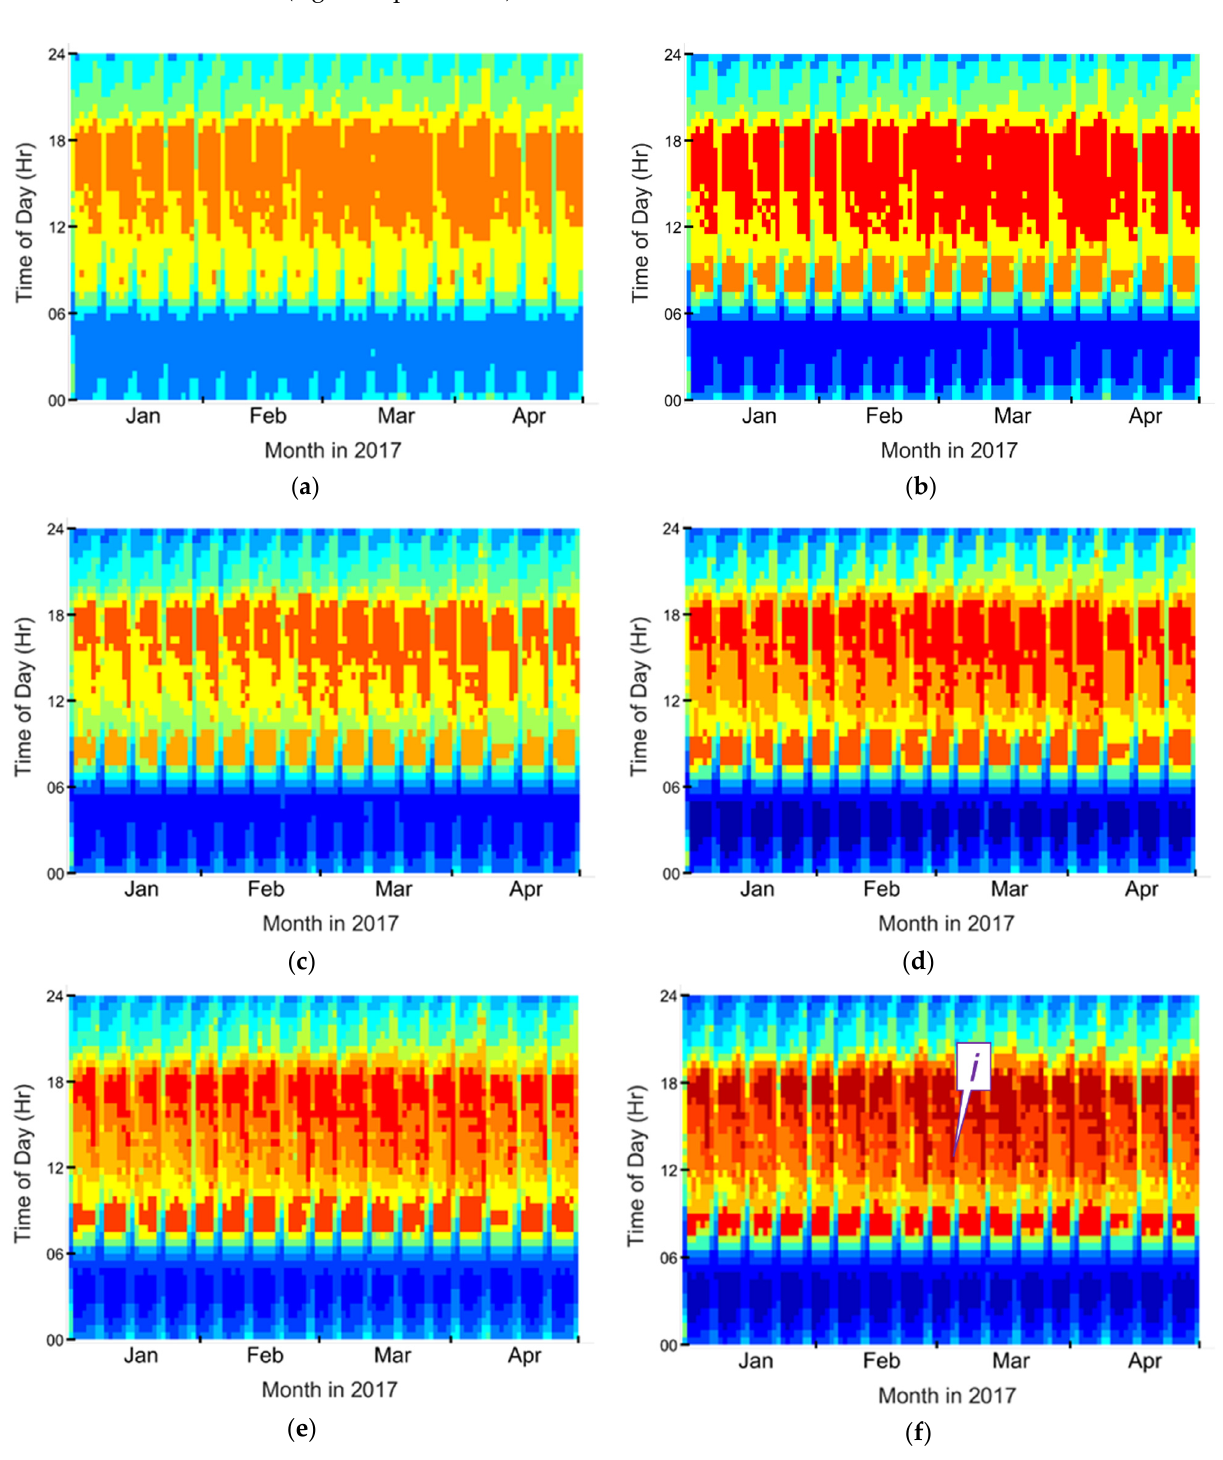
Figure 5. Temporal characteristics of traffic profiles for a different number of clusters (for January (Jan), February (Feb), March (Mar) and April (Apr) months of 2017); ( a ) number of clusters-5; ( b ) number of clusters–7; ( c ) number of clusters–9; ( d ) number of clusters–11; ( e ) number of clusters–13; ( f ) number of clusters–15.